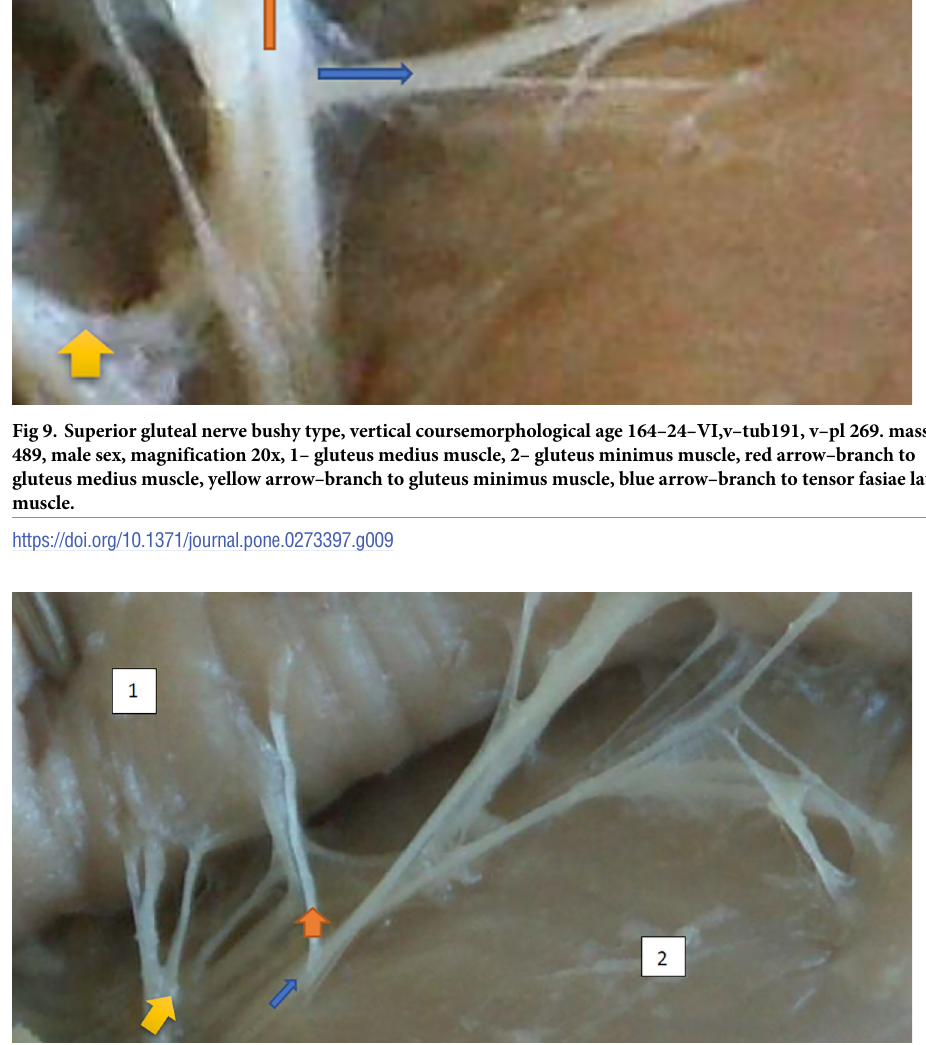
Fig 10. Superior gluteal nerve, bushy type, horizontal–oblique course, the net with variform meshes morphological age 169–25–VII,V–tub 200, V–pl 294,mass 690, male sex, magnification 20x. 1– gluteus medius muscle, 2– gluteus minimus muscle, red arrow–branch to gluteus medius muscle, yellow arrow–branch to gluteus minimus muscle, blue arrow–branch to tensor fasiae latae muscle.